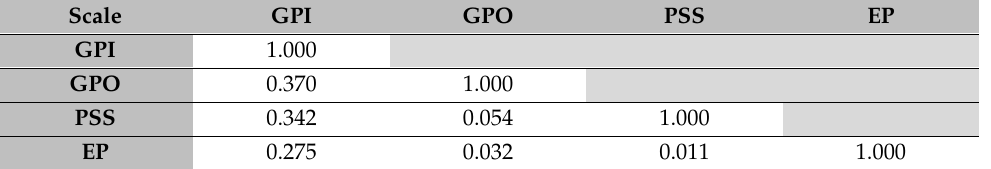
Table 6. Correlation values indicating discriminant validity.